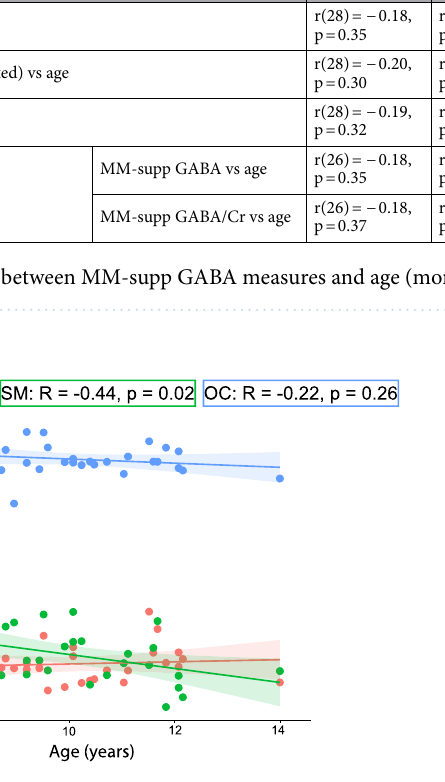
Figure 4. Correlation between GM ratio (fGM/[fGM + fWM]) and age. TH: Thalamus (red); SM: Sensorimotor cortex (green); OC: Occipital cortex